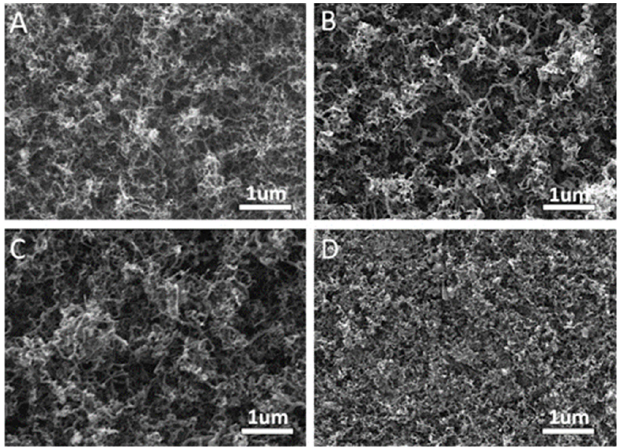
Figure 13. SEM images of the PAA/CNTs after CVD process using different Ni catalyst contents: ( a ) 0.1 molL -1 Ni content, ( b ) 0.5 molL -1 Ni content, ( c ) 1 molL -1 Ni content, and ( d ) 2 molL -1 Ni content tents: ( A ) 0.1 molL − 1 Ni content, ( B ) 0.5 molL − 1 Ni content, ( C ) 1 molL − 1 Ni content, . Reprinted with permission from Ref. [163] Copyright © 2023, American Chemical Society.